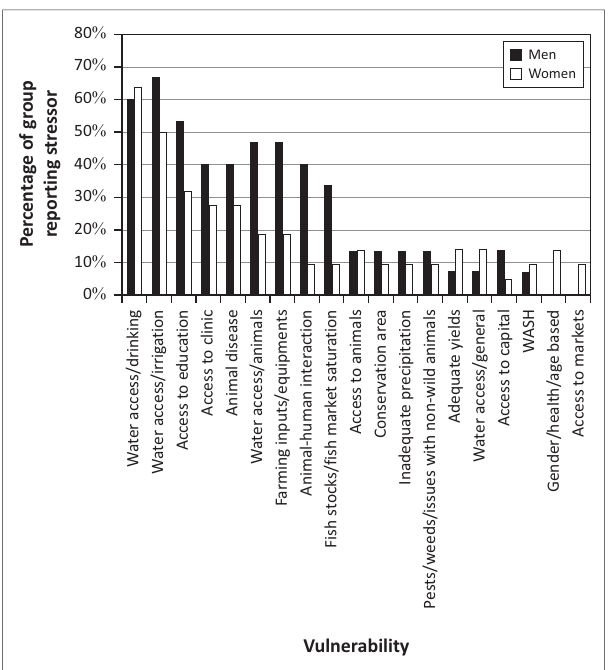
FIGURE 21: The gendered vulnerability context of Group W.